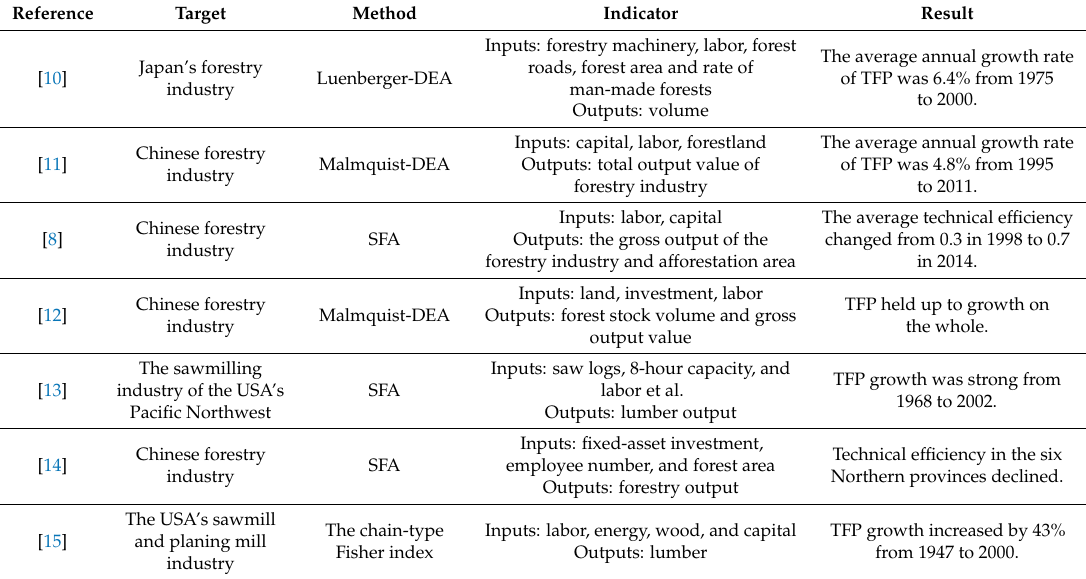
Table A1. Summary of previous literature on calculating the production efficiency of forestry- related